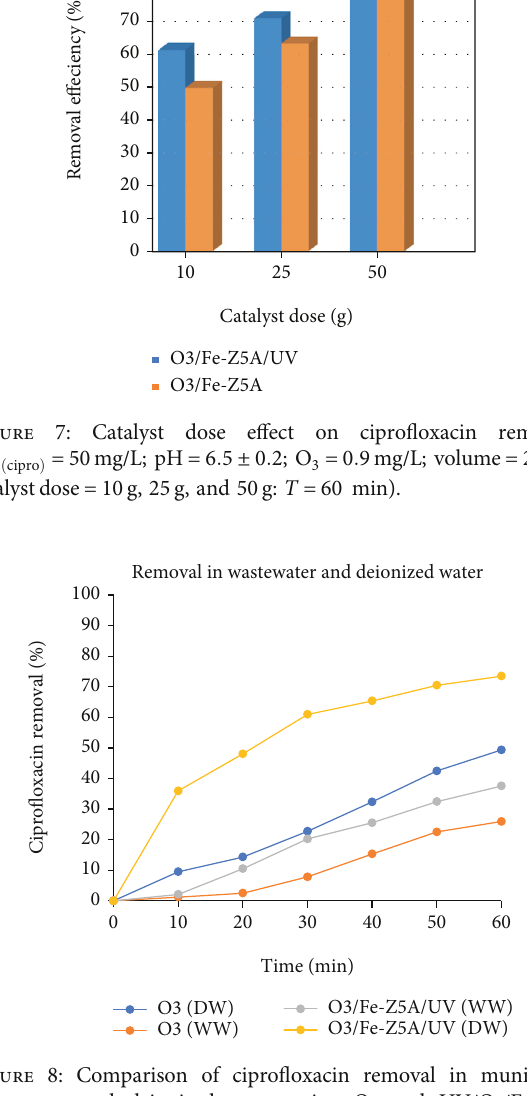
and UV/O /FeZ5A 3 3 = 6 : 5 ± 0 : 2 ; pH = DW ww